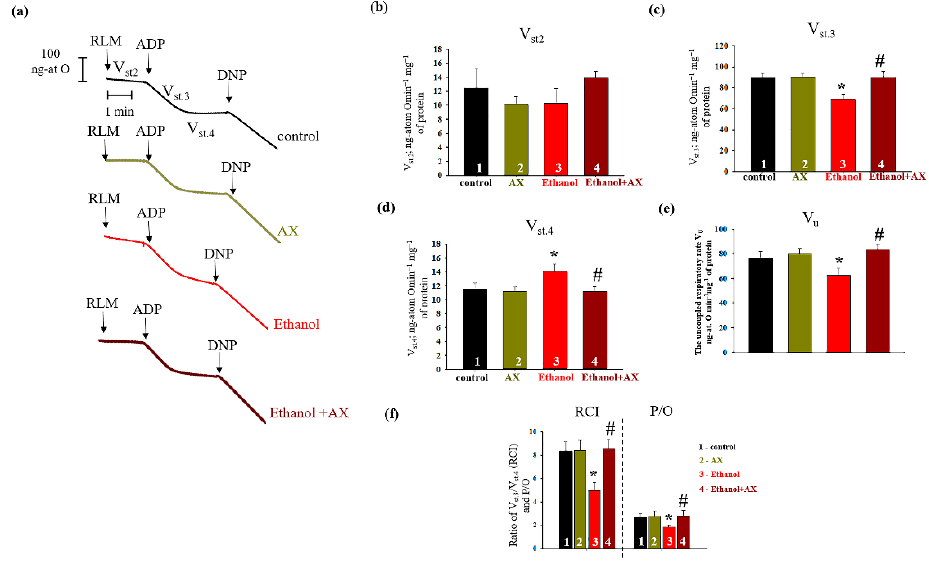
Figure 3. The effects of AX and Ethanol on the change of respiratory activities in RLM. ( a )—The curves of respiratory activities in state 2 (V st.2 ), 3 (V st.3 ), 4 (V st.4 ), and uncoupled respiration rate (V u ). Arrows showed the additions to RLM. The concentration of ADP was 200 µM. DNF was 30 µM. ( b )—quantitative analysis of RLM respiration rate in states 2 (V st.2 ); ( c )—quantitative analysis of RLM respiration rate in states 3 (V st.3 ); ( d )—quantitative analysis of RLM respiration rate in states 4 (V st.4 ); ( e )—quantitative analysis of the uncoupled respiration rate (V u ); ( f )—respiratory control in-